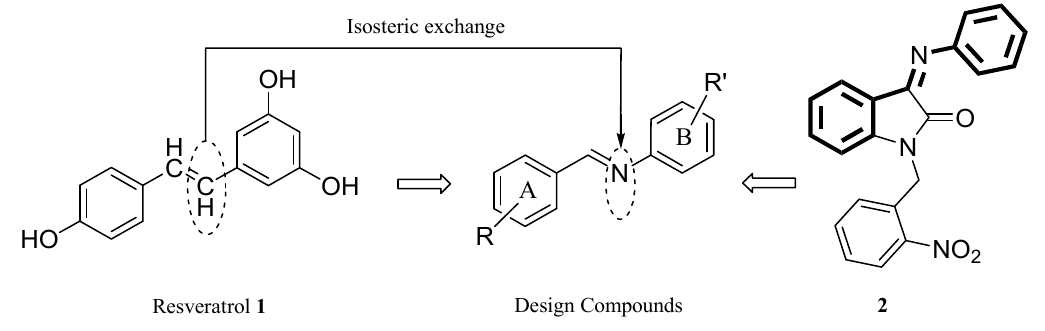
Figure 1. Design of imine resveratrol derivatives.